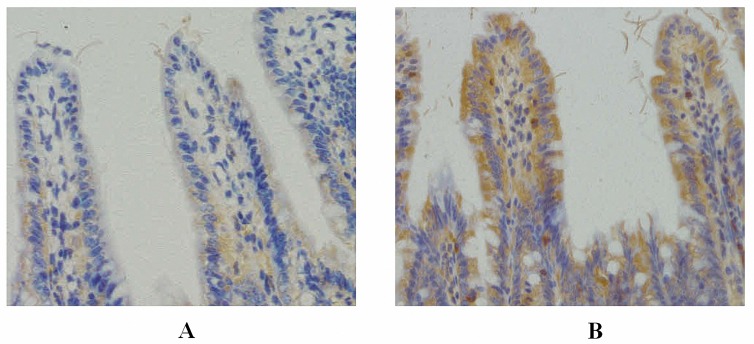
Expression of NF-κB p65 in the terminal ileum (×200; immunohistochemistry).A: Weakly positive expression of NF-κB p65 protein was detected in the mucosa of the terminal ileum in the SH group, and cytoplasm in a small amount of cells was light yellow with nucleus unstained; B: The cytoplasm in the cells of the OJ group showed enhanced brown yellow staining and visibly stained nucleus on the 7th day after operation.